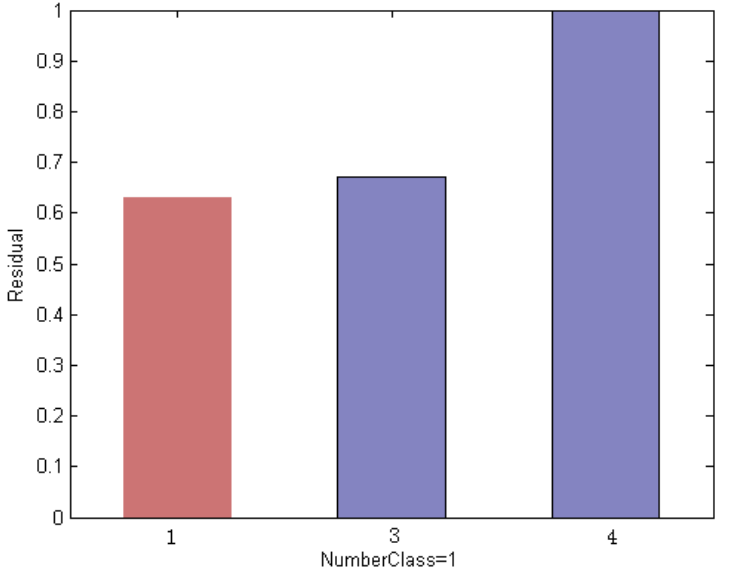
Figure 10. Reconstruction error of the test sample by each remaining class using an elimination scheme based on the Euclidean distance measurement, which still leads to incorrect classification results.